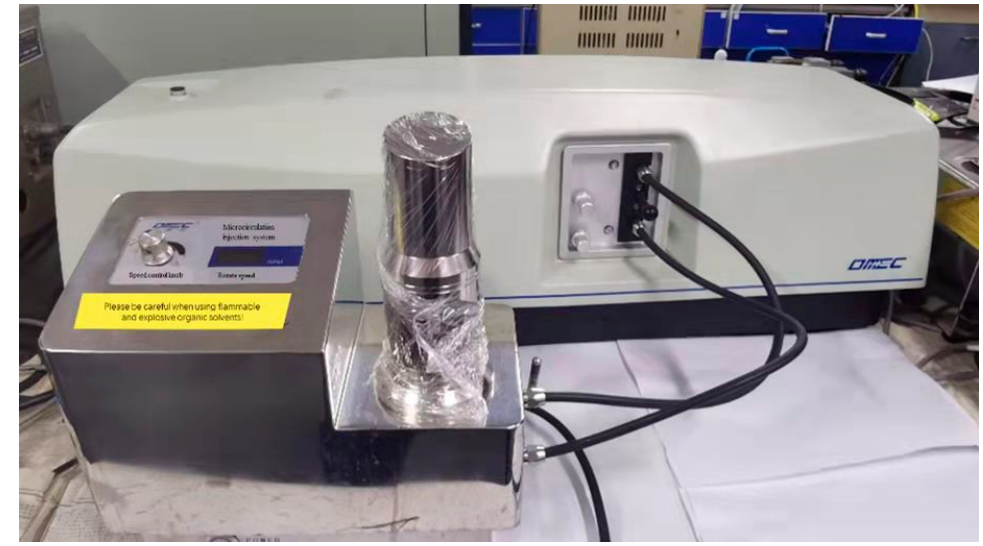
Figure 1. Laser particle size analyzer.